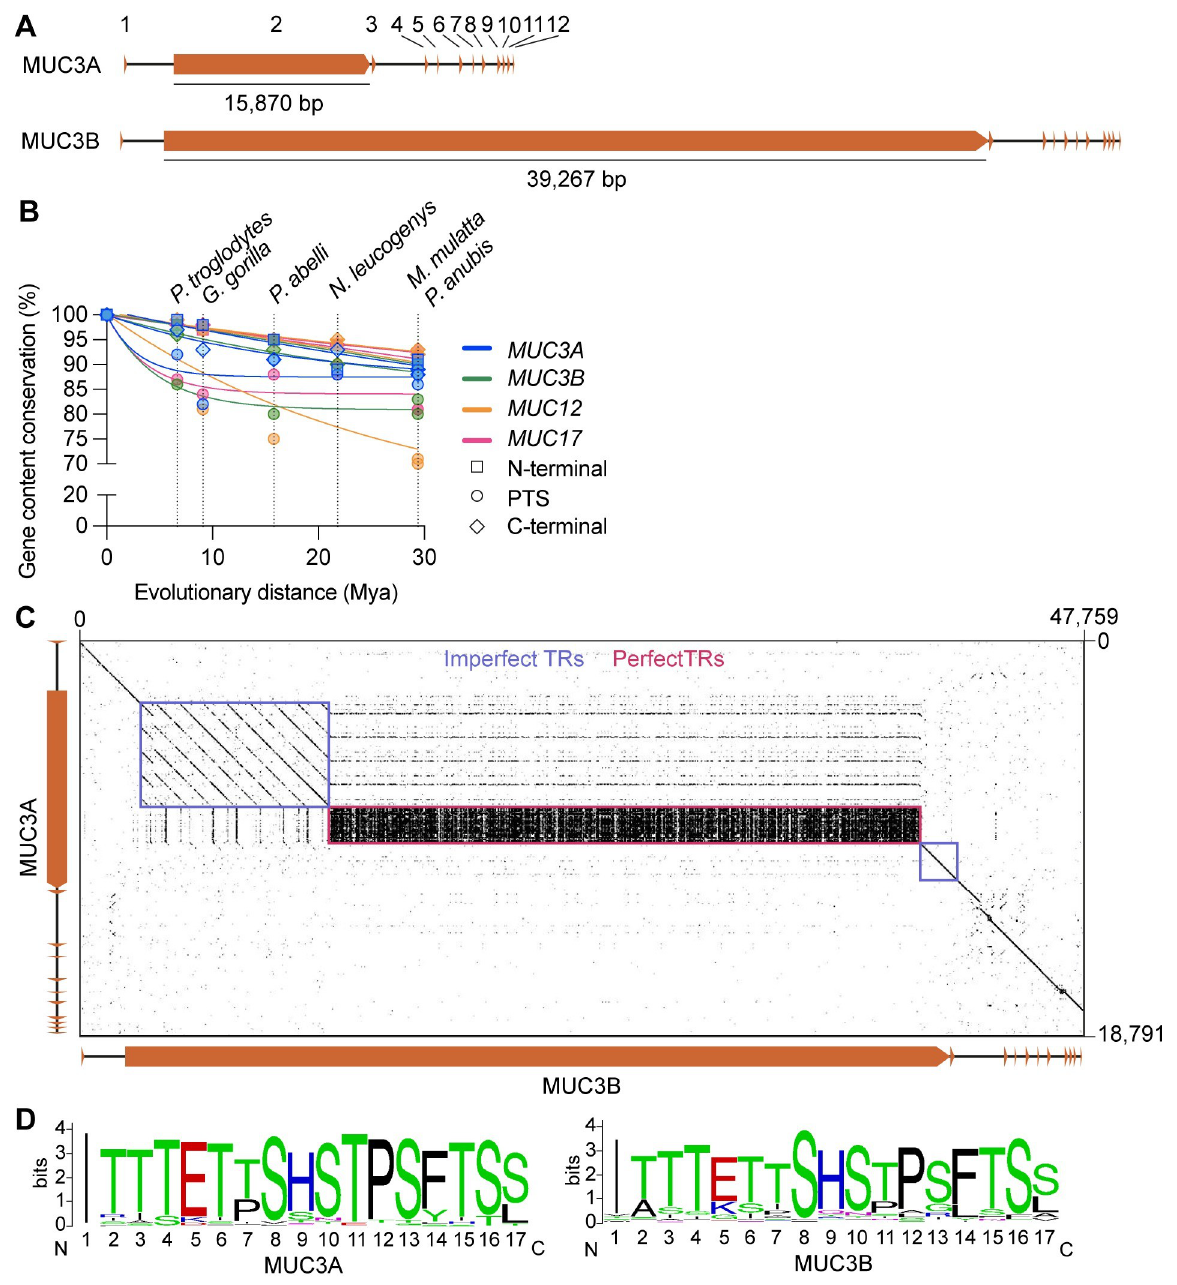
Fig 3. Comparison of genetic and structural features of MUC3A and MUC3B genes. (A) Exon structure and length of exon 2 of MUC3A and MUC3B . (B) The evolutionary rate of N-terminal-, PTS- and C-terminal-encoding exons in MUC3A , MUC3B , MUC12 , and MUC17 measured as gene content conservation (%) versus evolutionary distance (Mya). (C) Dot plot of pairwise sequence alignment of MUC3A and MUC3B identified imperfect (blue) and perfect (red) tandem repeat sequences in exon 2. (D) Sequence logo representation of 17 amino acids long consensus sequence in 166 and 549 perfect tandem repeats (TRs) in exon 2 of MUC3A and MUC3B , respectively. signals within the cCRE (Fig 4A). Moreover, we identified high signals for active chromatin markers H3K9ac and H3K4me3 within the MUC3A cCRE in the human small intestine and colon, while active chromatin signals in the stomach were either low or not detected. By